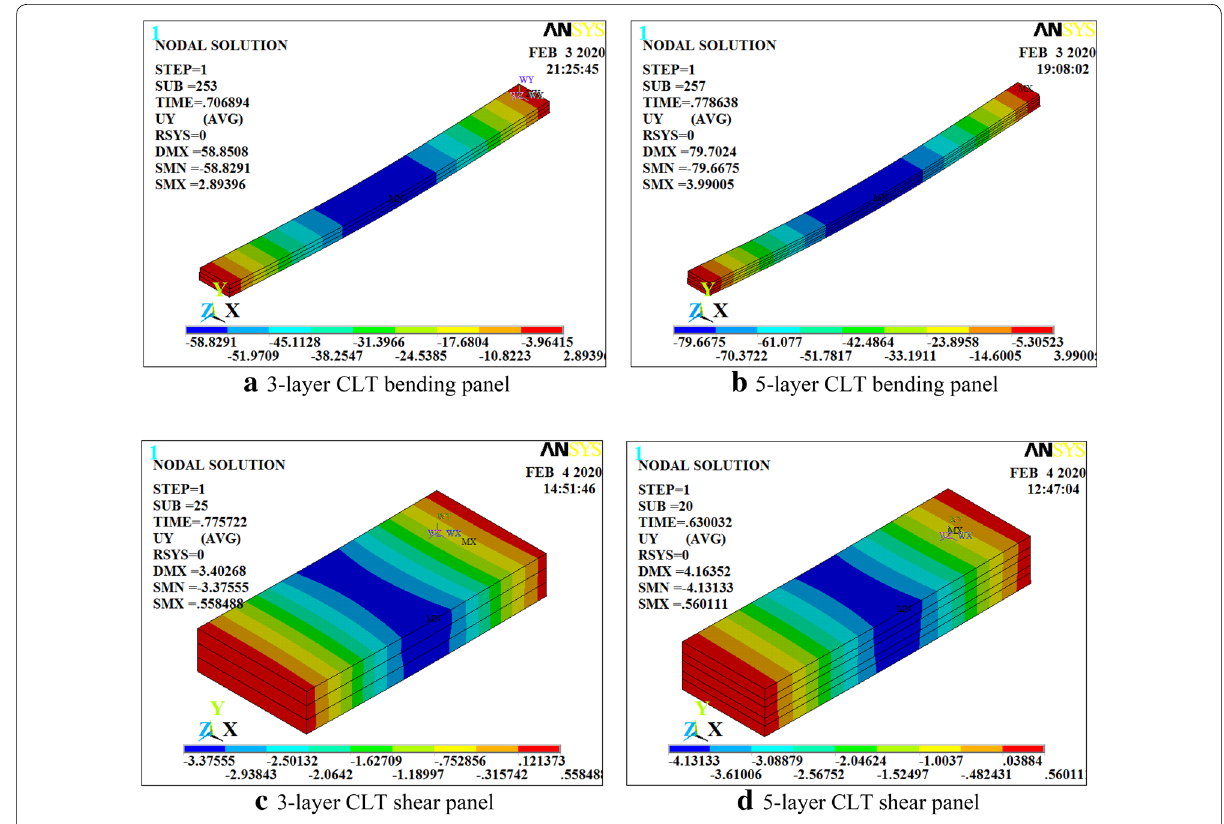
Fig. 13 Contour plots of the vertical deformation from the